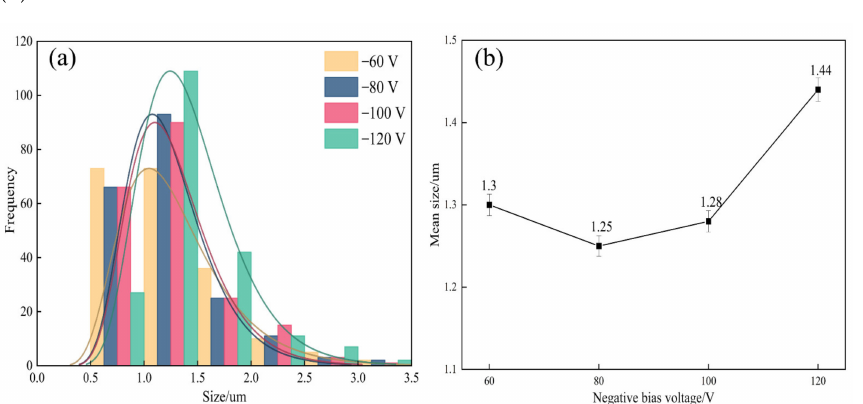
Figure 2. Statistical plots describing the large particles on the coating’s surface under different bias voltages: ( a ) histogram of frequency distribution; ( b ) trend of average particle